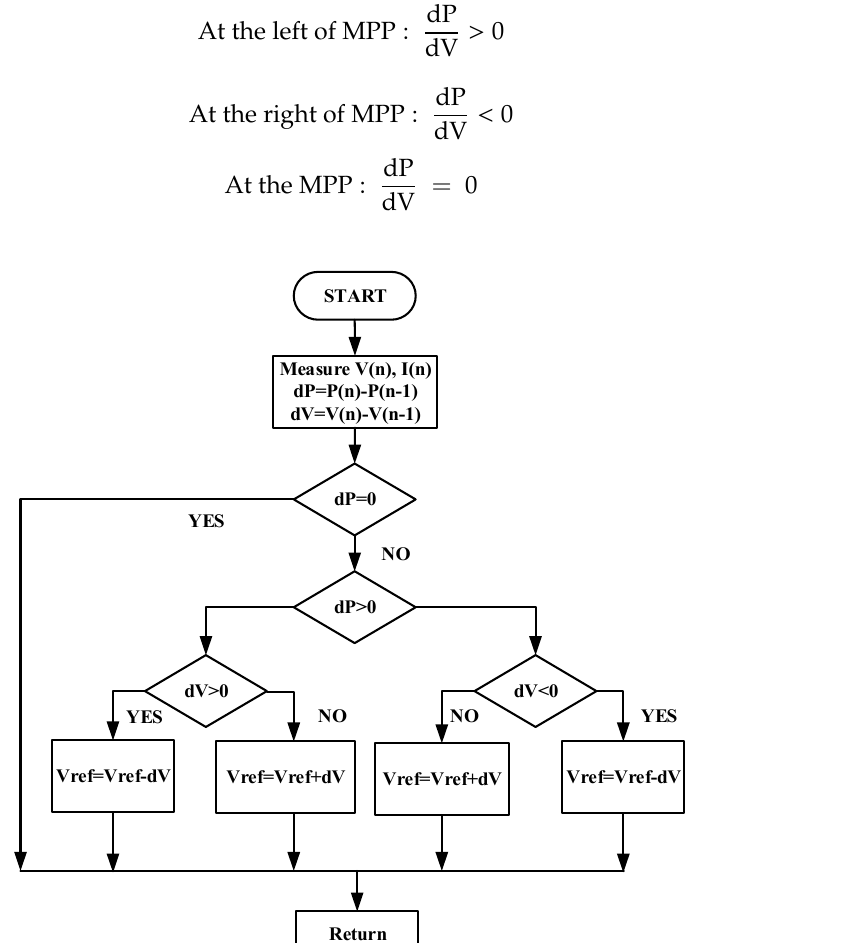
Figure 23. Perturbation and observation (P&O) algorithm flowchart.